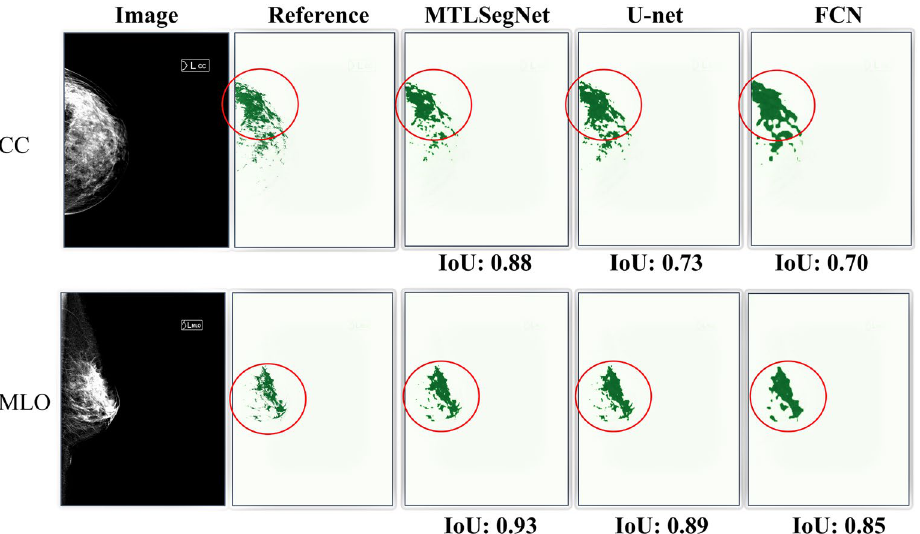
Figure 7. Dense-tissue segmentation outputs predicted by the MTLSegNet, U-net, and FCN networks on the KUH evaluation data. MTLSegNet successfully segmented the dense tissues, while FCN and U-net over- segmented the dense tissues by including the fat tissues within the breast area. For the visualization purposes, we outline the dense-tissue pixel area using the red